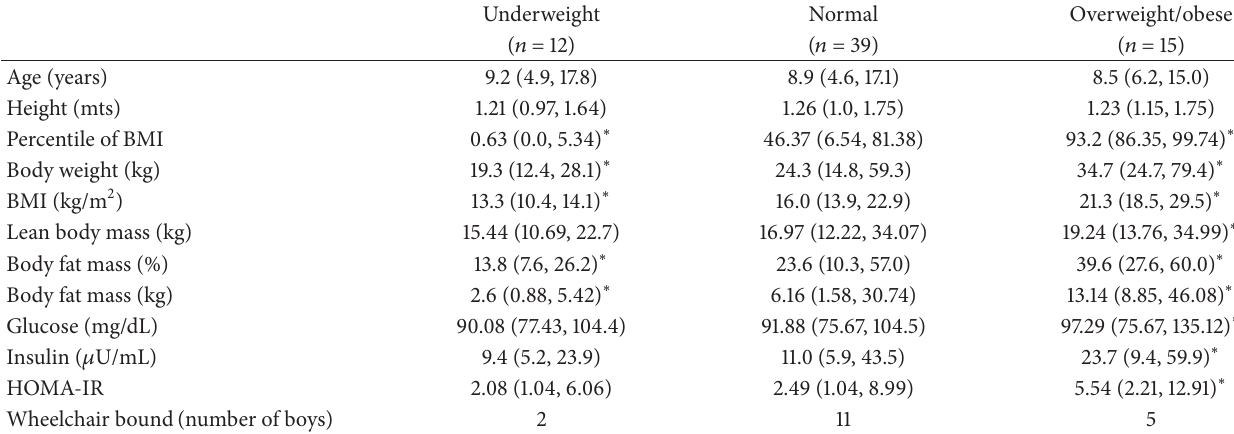
Table 2: Characteristics and metabolic variables according to nutritional status in DMD/BMD patients from 4 to 18 years of age a .